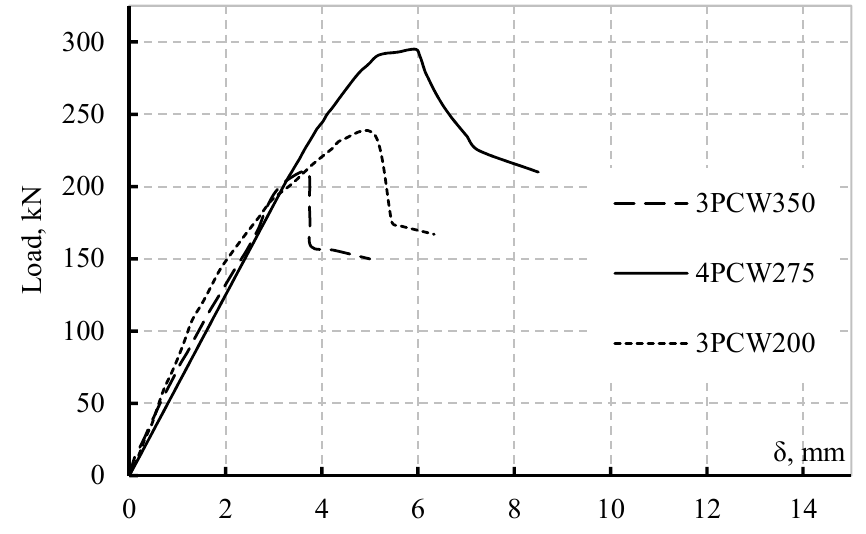
Figure 5. Load deflection curves of the specimens.